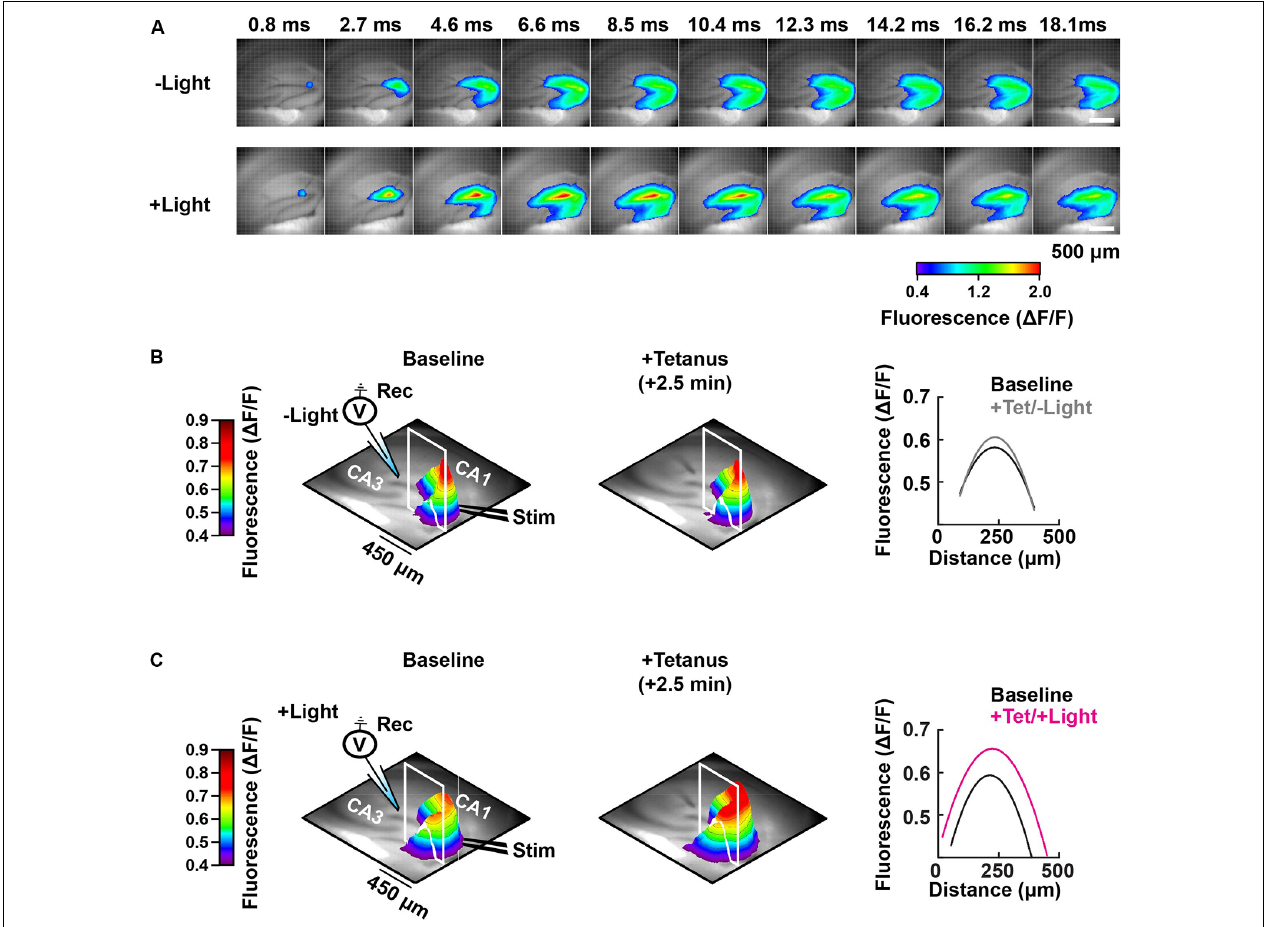
FIGURE 5 | Spatial-temporal mapping of the PAC-induced enhancement of DG depolarization. (A) Representative time-lapse images of the VSD fluorescence change (depicted in pseudocolor scale) after tetanus, collected either without ( − Light; upper row) or with photostimulation to activate PAC (+Light; lower row). (B) Left and middle: pseudo-colored 3D graph of the averaged peak VSD fluorescence change in the hippocampal DG region before (Baseline) and after tetanic stimulation (+Tetanus). The 3D fluorescence images were calculated as the ratio of the fluorescence changes before and after tetanus. Right: fluorescence profiles across the lines in the 3D fluorescence distribution (white line of left and middle) fitted with a parabola. Black, before tetanic stimulation (Baseline); grey, after tetanic stimulation without photostimulation to activate PAC (+Tet/ − Light); magenta, after tetanic stimulation with the photostimulation (+Tet/+Light). The same analysis shown in panel (B) which was performed without PAC activation ( − Light; n = 56 images/7 slices/2 mice), was repeated in panel (C) with PAC (+Light; n = 64 images/8 slices/2 mice) activation,